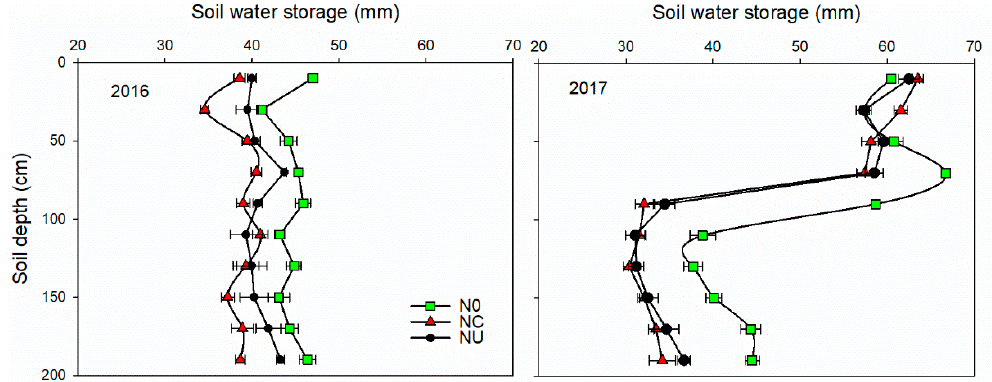
Figure 6. Soil water storage with three treatments at the R5 stage in 2016 and 2017 as follows: no N application (N0), combined controlled release urea and normal urea at a ratio of 1:2 (NC), and normal urea alone (NU).